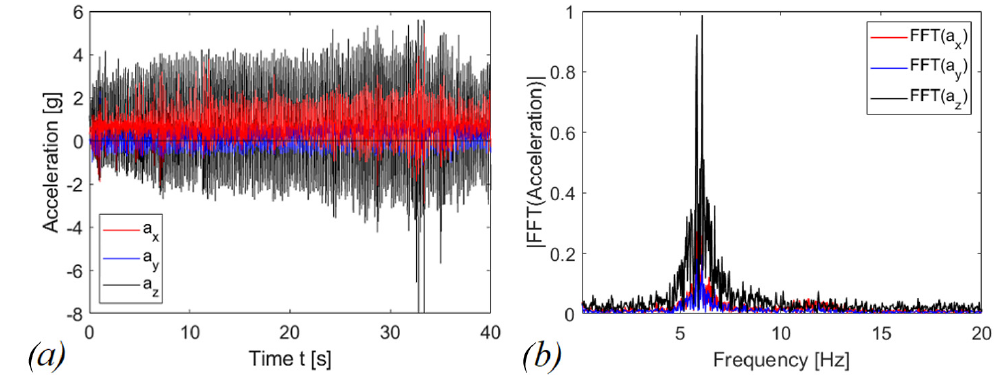
Figure 14. Shaking signal of ( a ) accelerogram ( b ) Fast Fourier Transform.